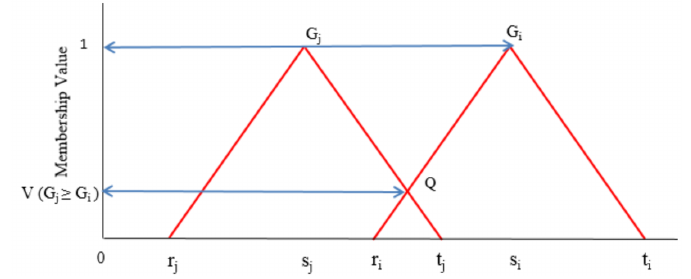
Figure 3. Highest interaction points between G j and G i